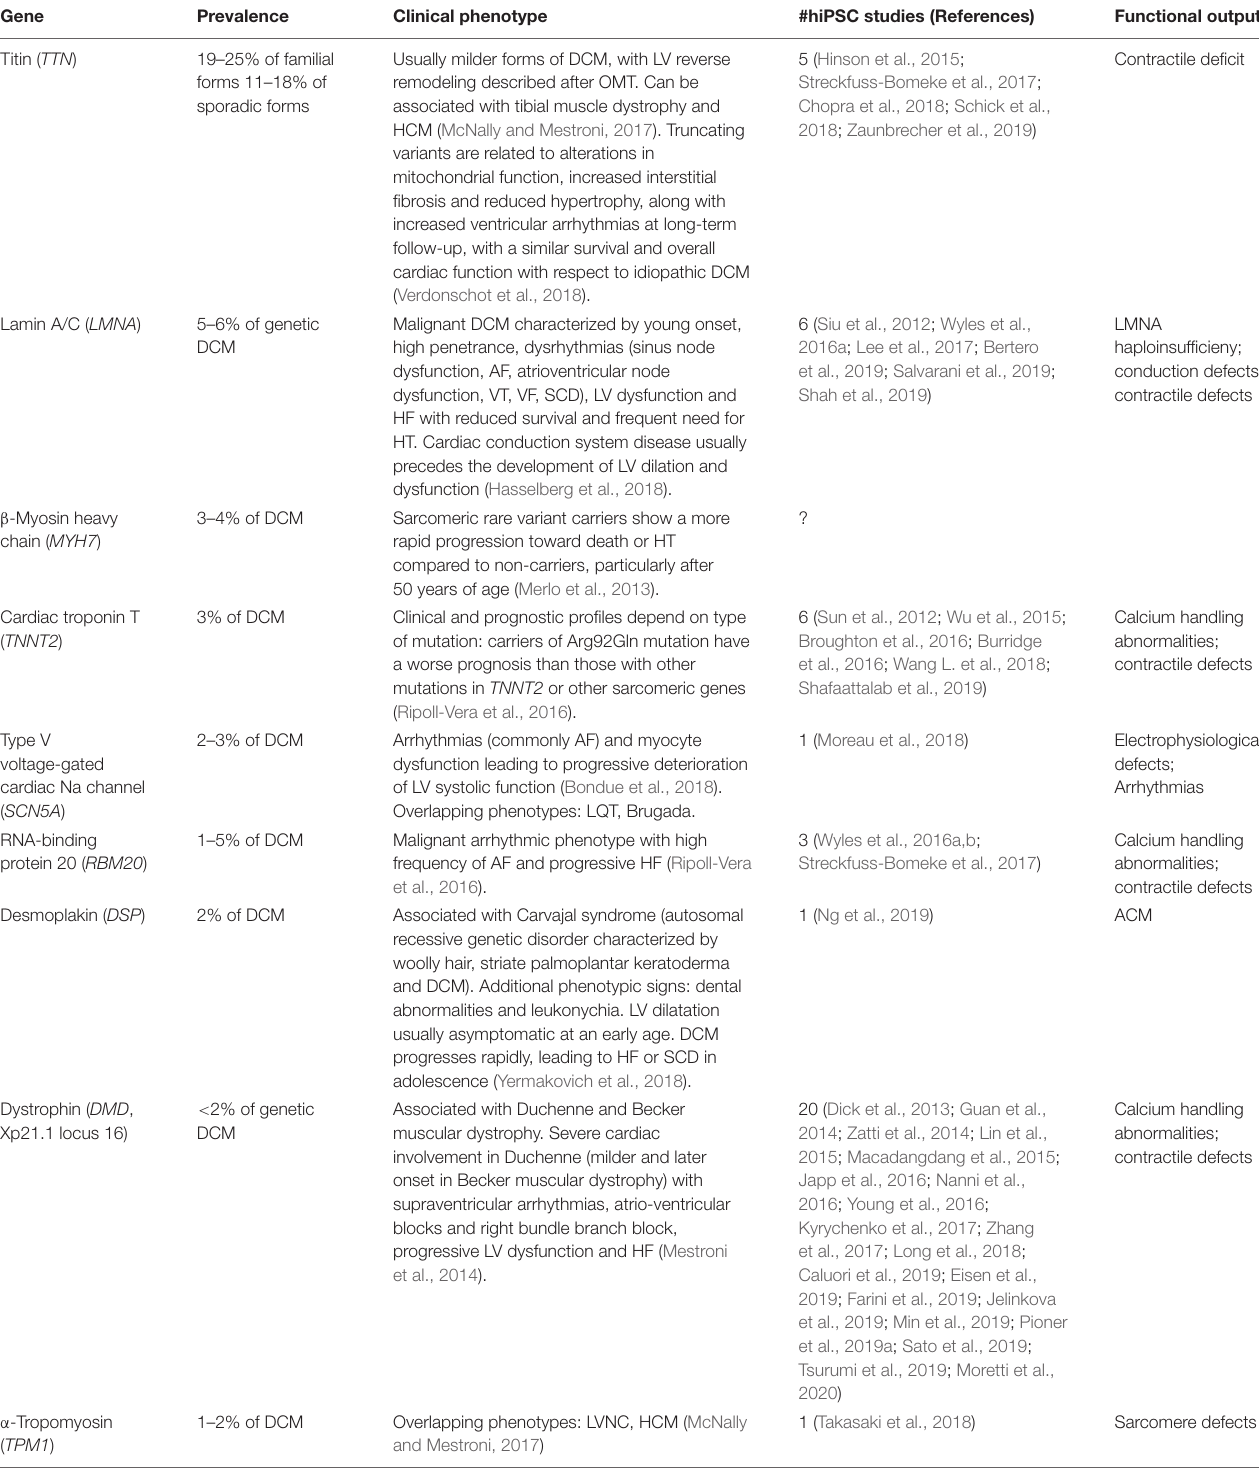
TABLE 1 | Principal pathogenic gene mutations described in genetic DCM along with their clinical and cellular phenotype.